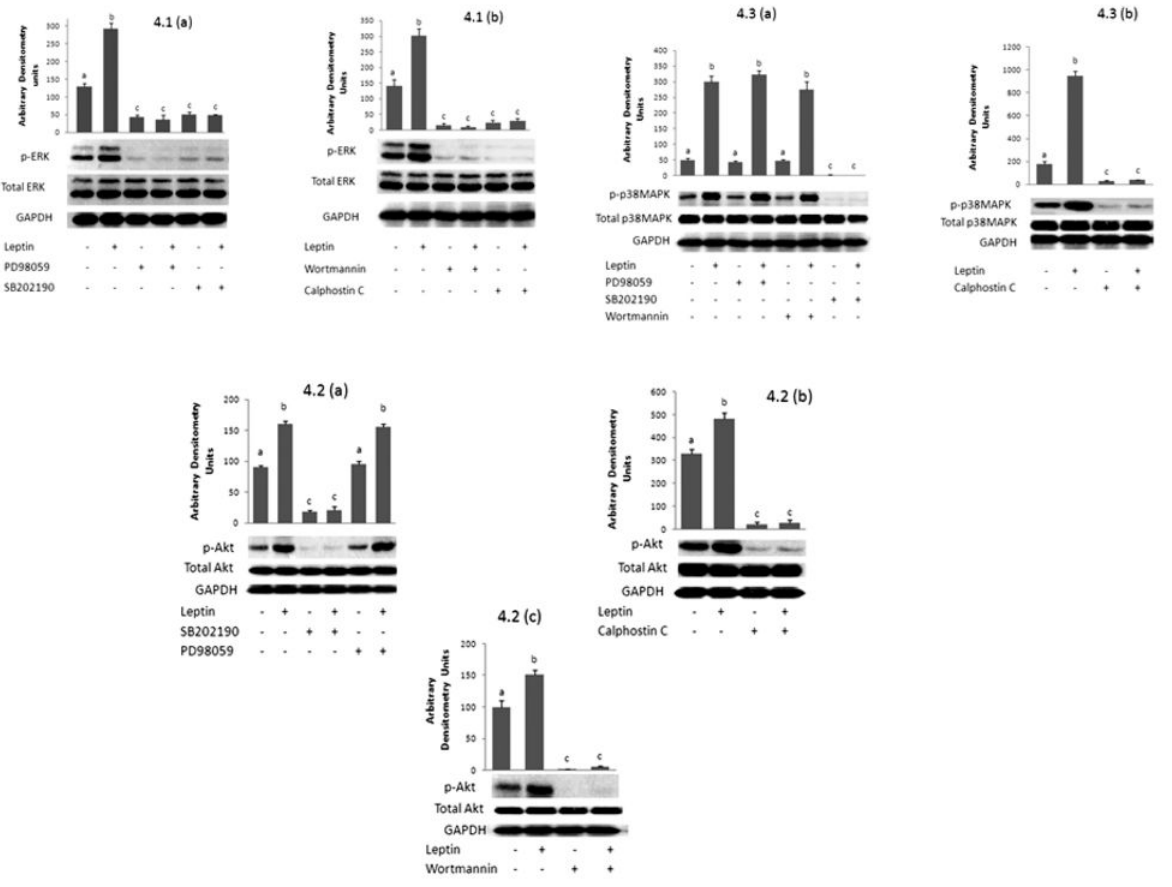
Figure 4. Positioning ERK, PI3K, p38MAPK, and PKC, with respect to each other. Effect of leptin (10 nM, 50 min)